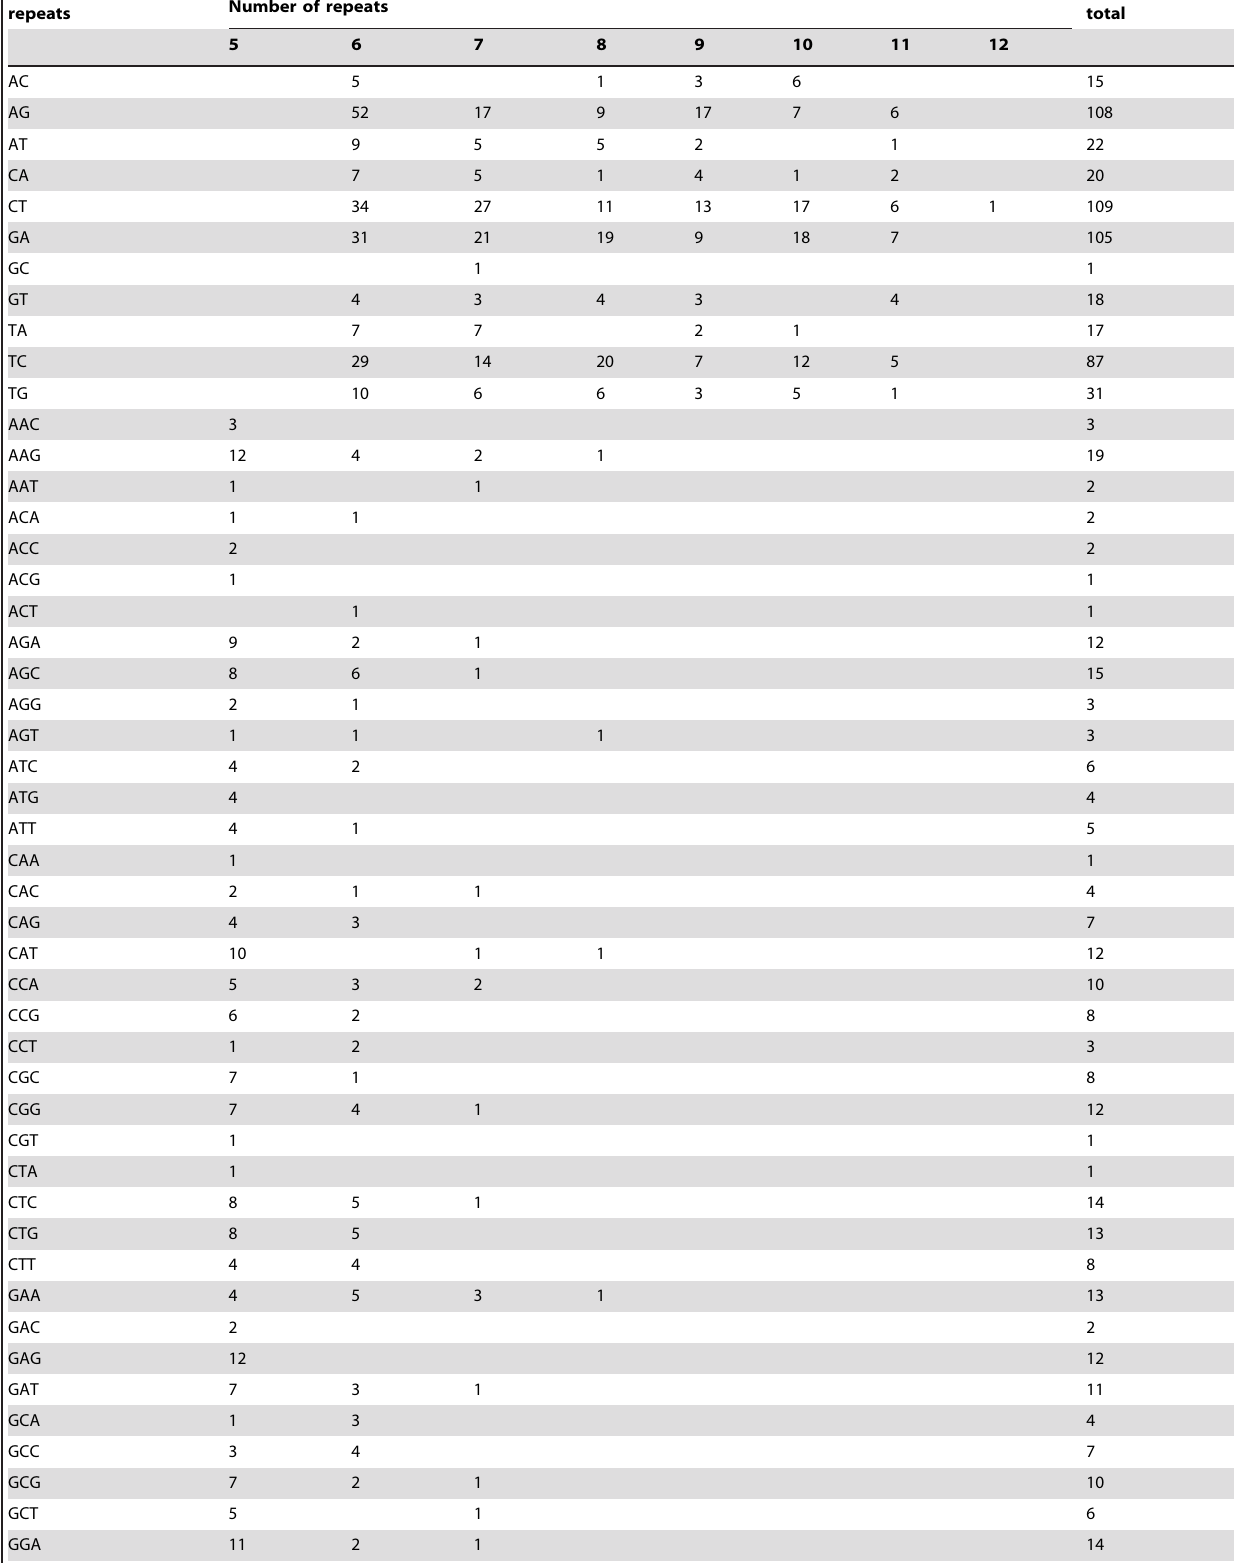
Table 6. Repeats of di- and